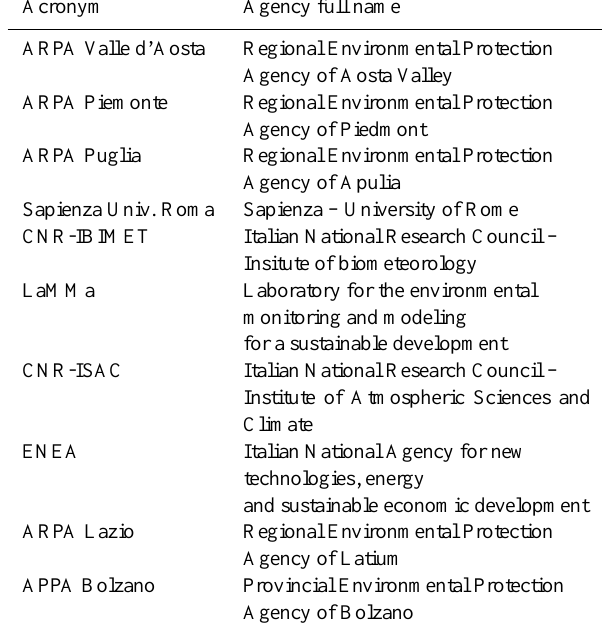
Table 1. List of participating agencies and their